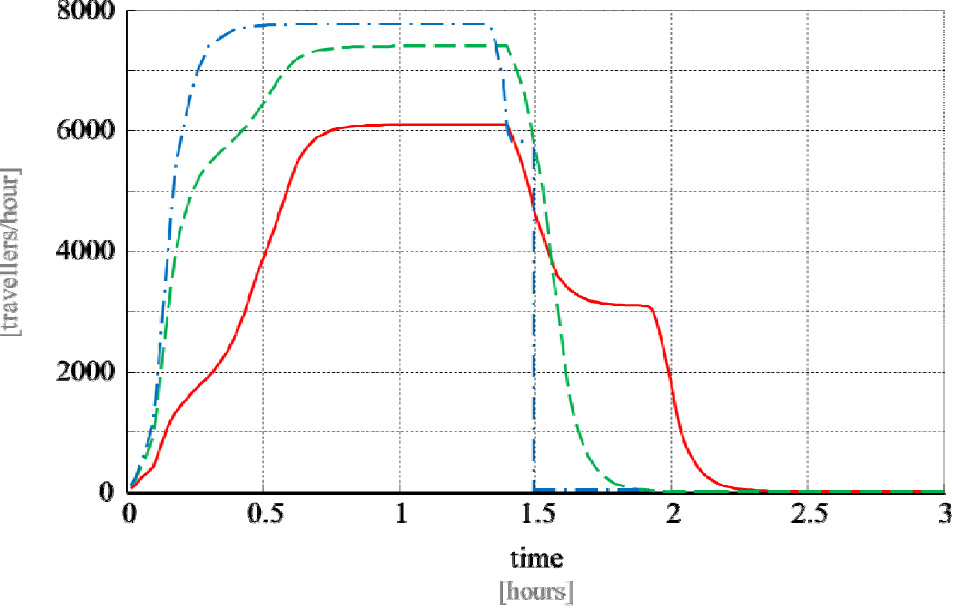
Figure 8. Network outflow rates: red solid line, compliance level 2; green dashed line, compliance level 7; blue dash-dotted line, compliance level 10 (see Table